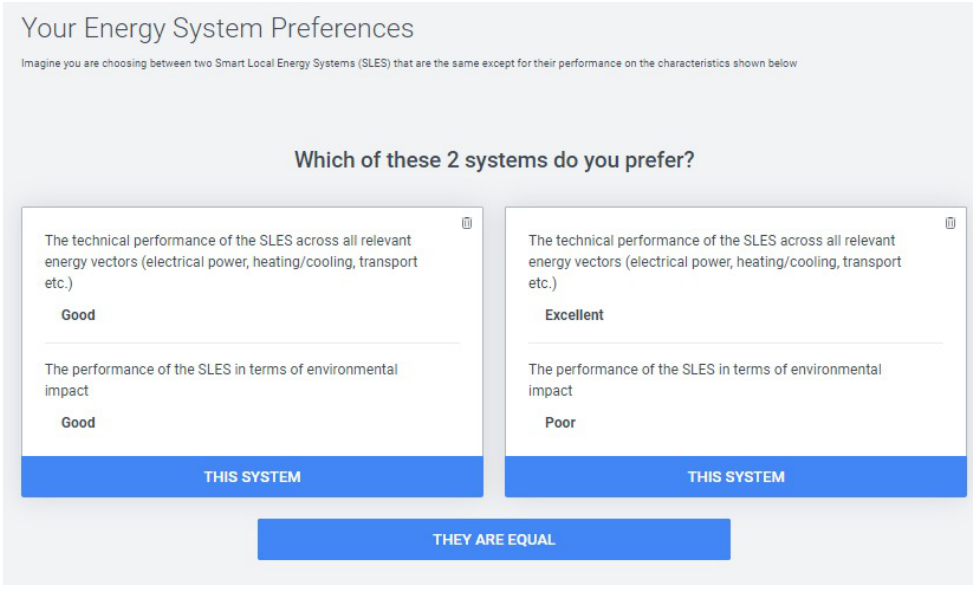
Figure 3. Example pairwise comparison question from the 1000minds